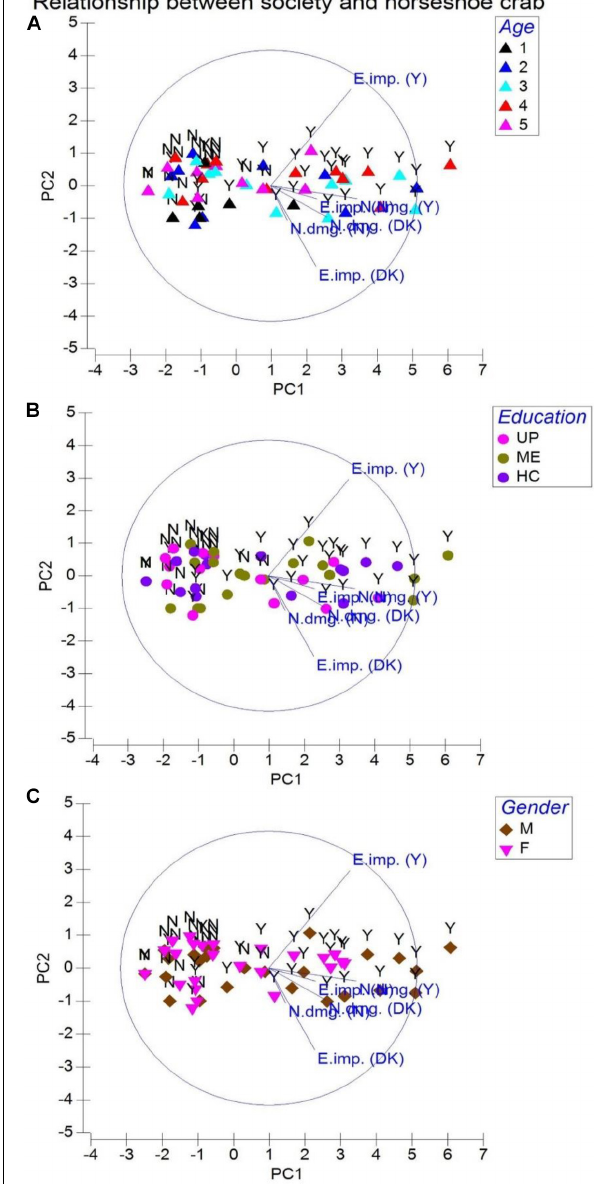
FIGURE 4 | Principal component analysis for society relationships with the horseshoe crab Tachypleus gigas. Abbreviations are E. imp. = ecological importance, N. dmg. = net damage, DK = don’t know, Y = yes, and N = no. Legends represented by age are 1 = 18–24 (Group 1), 2 = 25–34 (Group 2), 3 = 35–44 (Group 3), 4 = 45–54 (Group 4), and 5 = 55–64 (Group 5). Education is denoted with UP = upper primary, ME = middle elementary, and HC = high school. Gender is represented by M = male and F = female